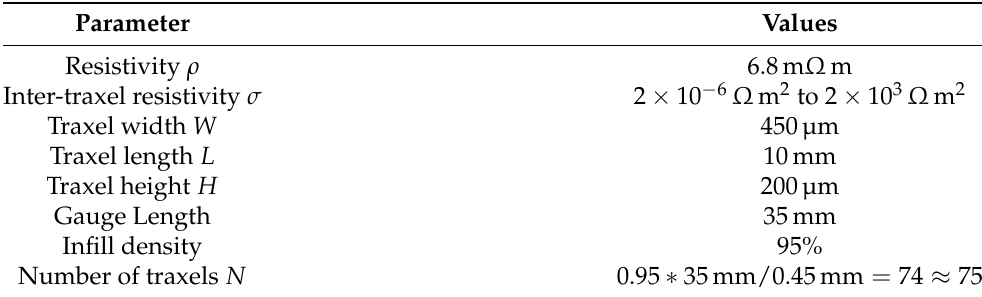
Table 4. Model parameters used for the constriction-resistive strain sensor calculations, based on the work conducted by Mousavi et al.